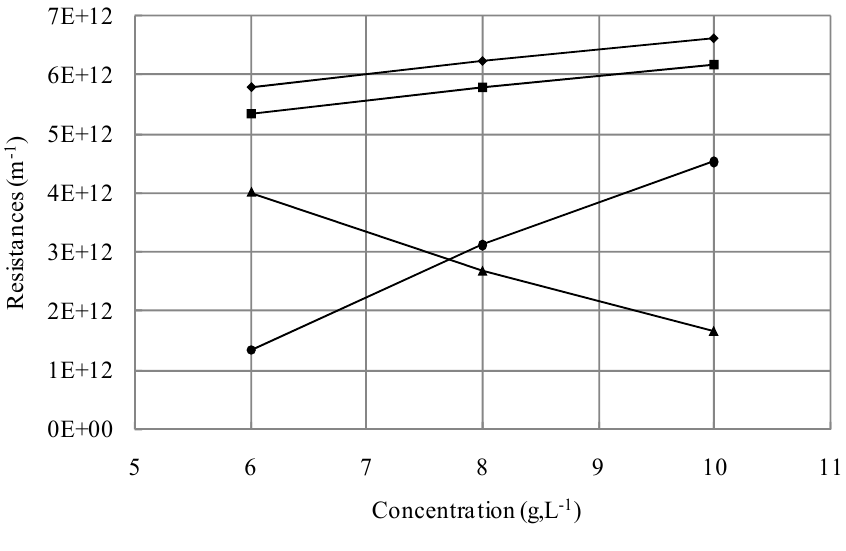
Figure 5. Effect of initial cell concentration of S. cerevisiae on cake resistances (  R ▲ R ; ● R if rf